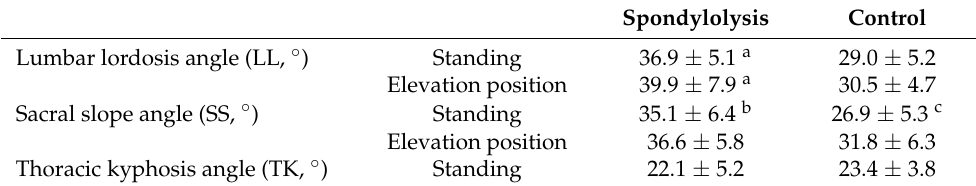
Table 1. Spinal alignment in spondylolysis patients and controls. Spondylolysis Control Lumbar lordosis angle (LL, ◦ ) Standing 36.9 ± 5.1 a 29.0 ± 5.2 Elevation position 39.9 ± 7.9 a 30.5 ± 4.7 Sacral slope angle (SS, ◦ ) Standing 35.1 ± 6.4 b 26.9 ± 5.3 c Elevation position